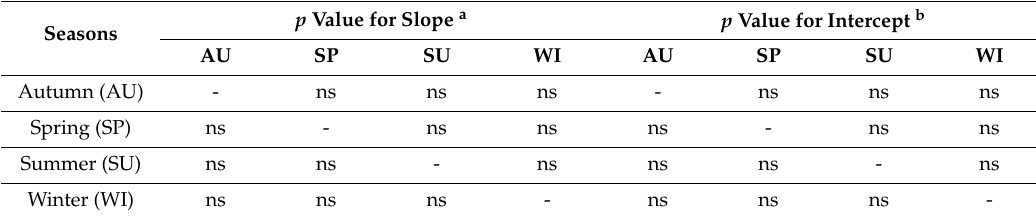
Table A2. p values for slope and intercept comparisons of the LSR analyses in Table S1. The differences among slopes were assessed by comparing 95% CI. When the slopes were not significantly different, the differences between elevations were estimated by ANCOVA (with body mass as a covariate). p Value for Slope a p Value for Intercept b Seasons AU SP SU WI AU SP SU WI Autumn (AU) - ns ns ns - ns ns ns Spring (SP) ns - ns ns ns - ns ns Summer (SU) ns ns - ns ns ns - ns Winter (WI) ns ns ns - ns ns ns -